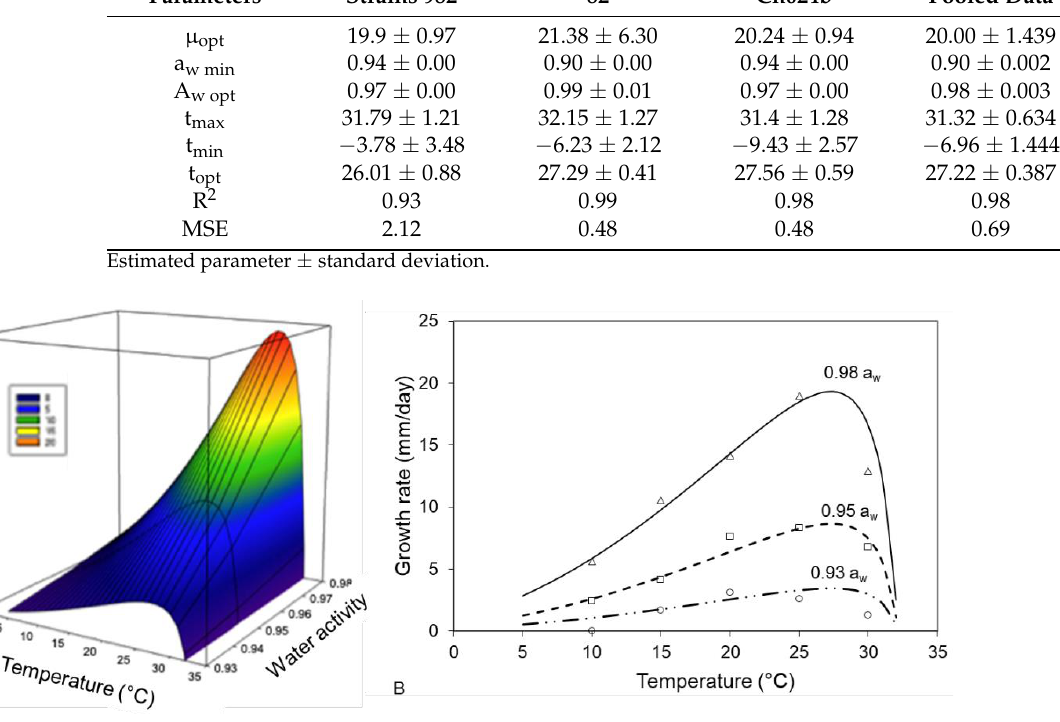
Figure 3. Cardinal fitted model of F. asiaticum (strain 082). ( A ) growth rate (mm/day) estimated response surface and ( B ) growth rates (mm/day) at different a w levels ( , 0.93 a w ) and fitted to the cardinal model.